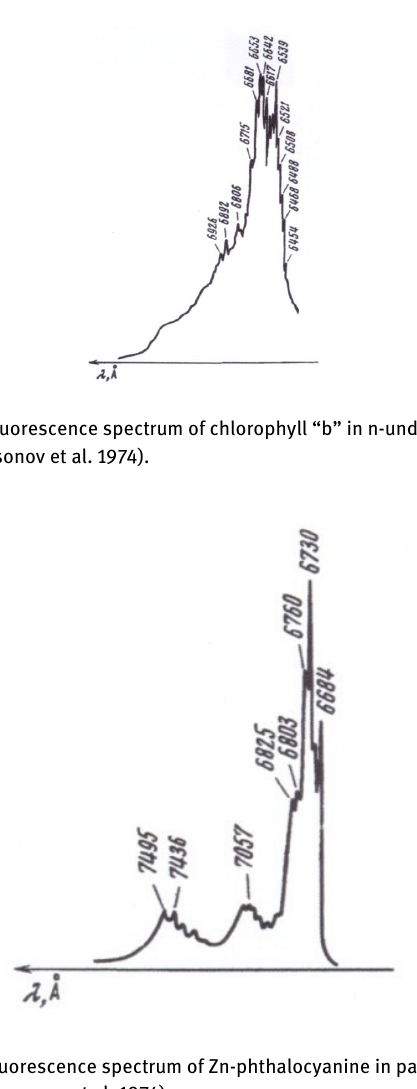
nescence of FHPs with possible prebiotic compounds (Si- monia and Simonia